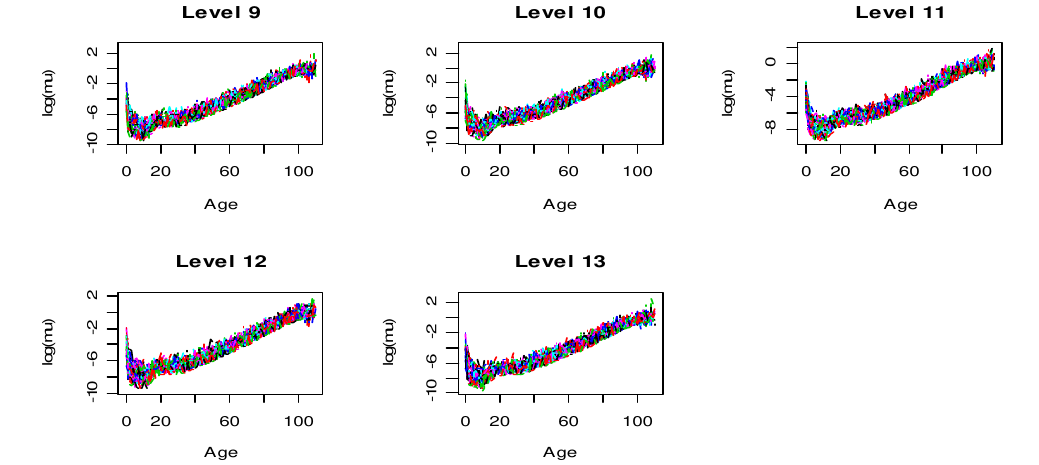
Fig. 5. Artificial log death rates – ASLC